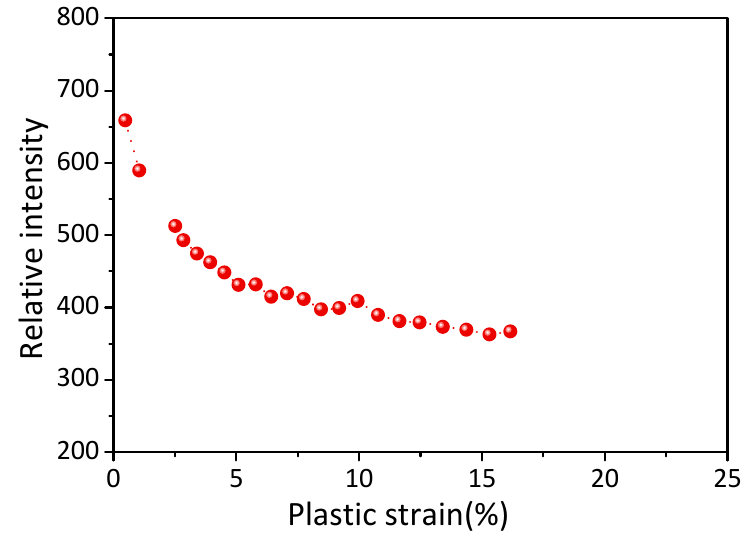
Figure 6. Intensity evolution of the {12 6 6} β diffraction peak.